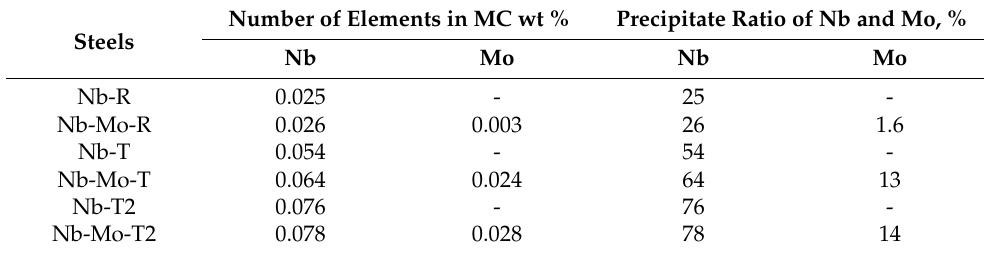
Table 3. Quantitative results of phase